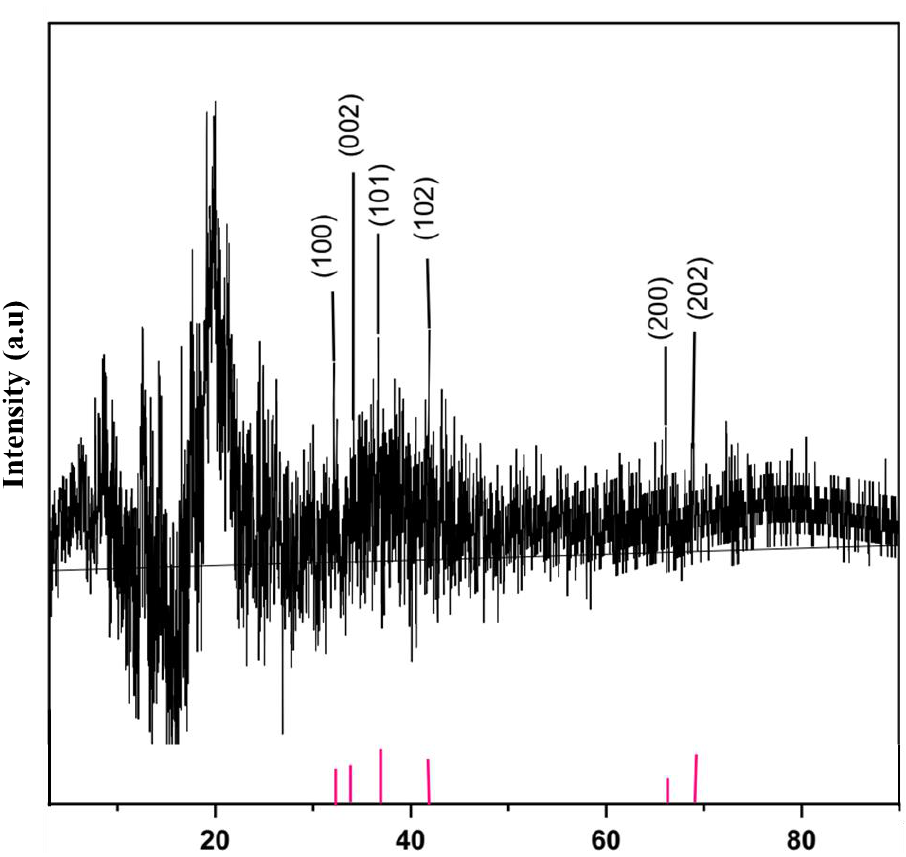
Figure 5. XRD pattern of 2Nph-BU-Cs/ZnONPs-5% composite.